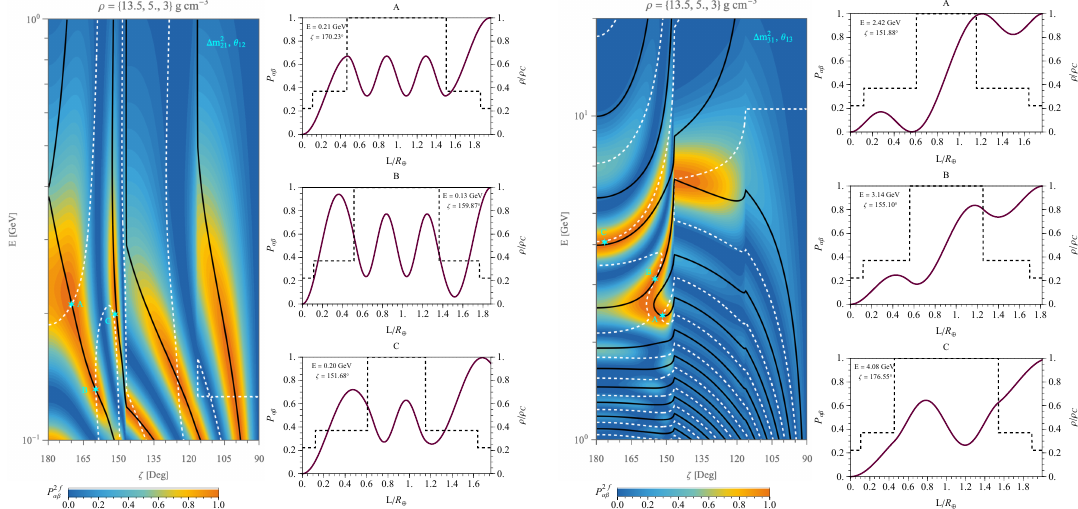
Figure 4 . Oscillograms for three-layer Earth matter profile with ρ = { 13 . 5 , 5 , 3 } g cm − 3 for the core, lower mantle, and upper mantle, respectively. The lines represent the parameters where the conditions W = 0 (black), and W = 0 (white dashed) are satisfied. We present three examples 0 3 where both conditions are (almost) fulfilled: points “A” and “B”, where there is a parametric resonance, and point “C” where there is a large amplification in the oscillations. We further present the probabilities as function of the traveled distance inside the Earth together with the matter profile normalized to the Core